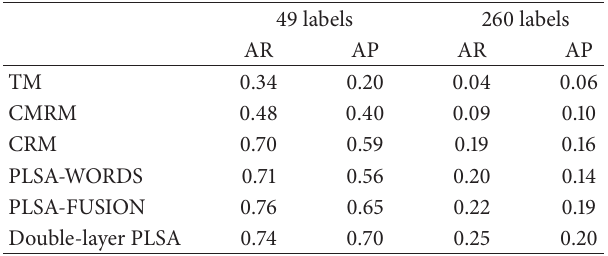
Table2:Theresultsofcontrastexperiments:AR(averagerecall)and AP (average